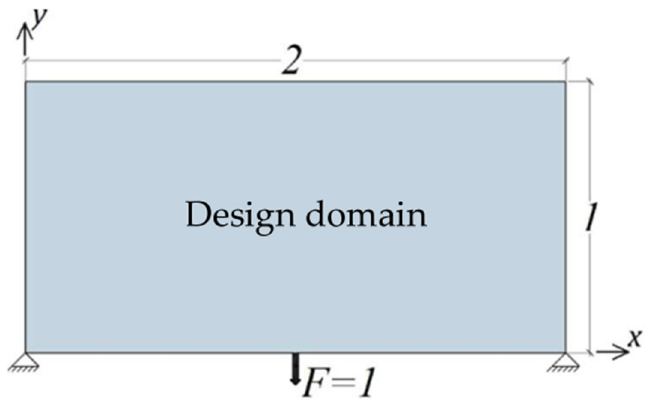
Figure 6. Problem definition of the pinned-pinned plate: design domain, loading, and supports.